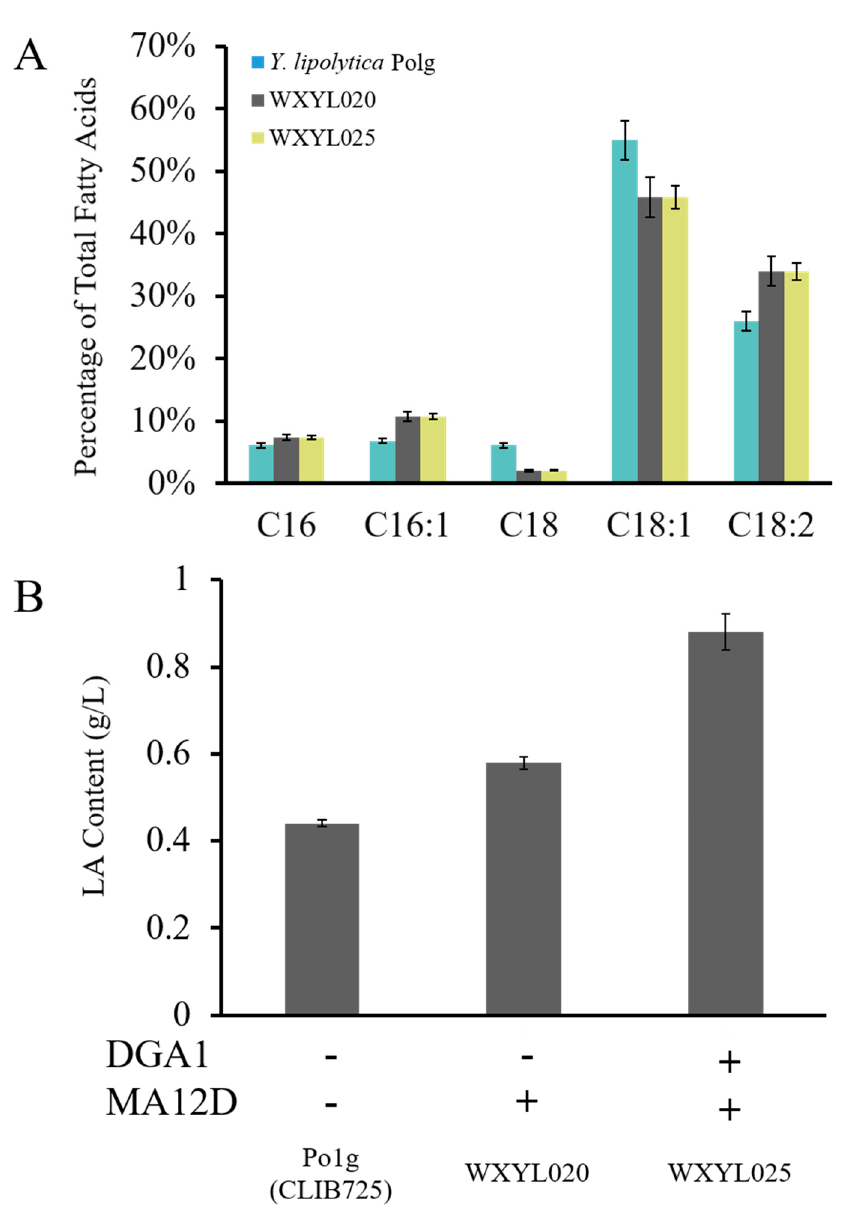
Figure 3. ( A ) Fatty acid distribution comparisons for WXYL020 and control strain wild Y. lipolytica Po1g grown in shake flasks. C16 methyl palmitate; C16:1 methyl palmitoleate; C18 methyl stearate; C18:1 methyl oleate; C18:2 methyl linoleate. ( B ) Analysis of strains overexpressing DGA1 or / and MA12D. LA contents of strains were analyzed after 72 h of culture. Lipid samples were performed in triplicate.